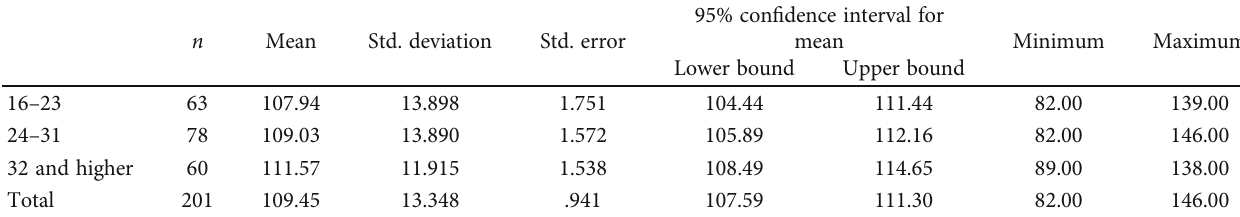
Table 4: One-way ANOVA for the role of age in university students ’ HCA. Sum of squares df